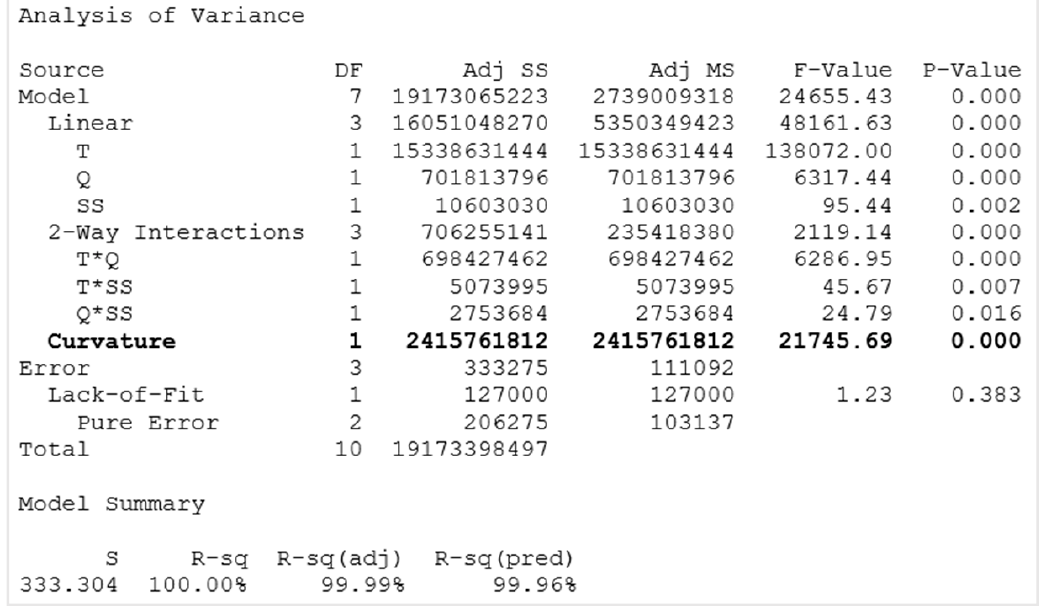
Figure 5. Analysis of variance of factorial regression.